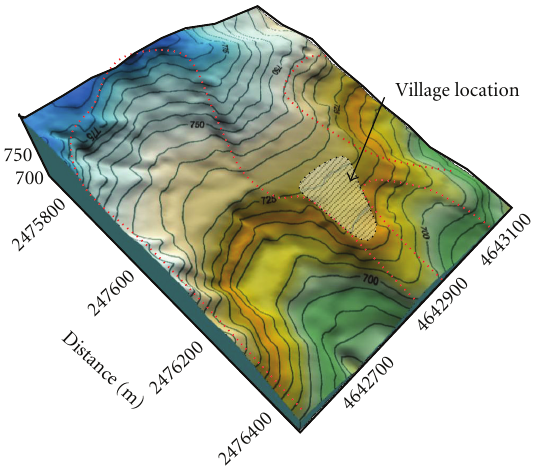
Figure 4: Morphology of the area. Dotted lines outline niches induced by landslides that occurred in the